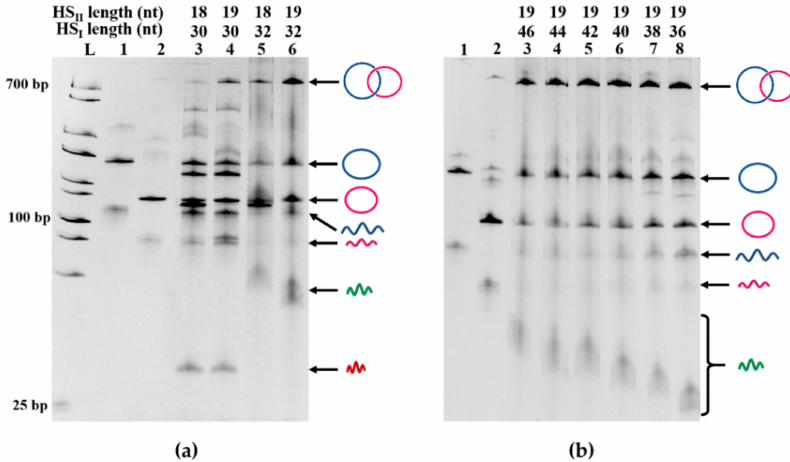
Figure 3. Catenation of L DNA α and L DNA β using two holder strands of various lengths. ( a ) Effect of the length of shorter holder strand HS II on the catenation; ( b ) Effect of the longer holder strand HS I when combined with 19-nt HS II